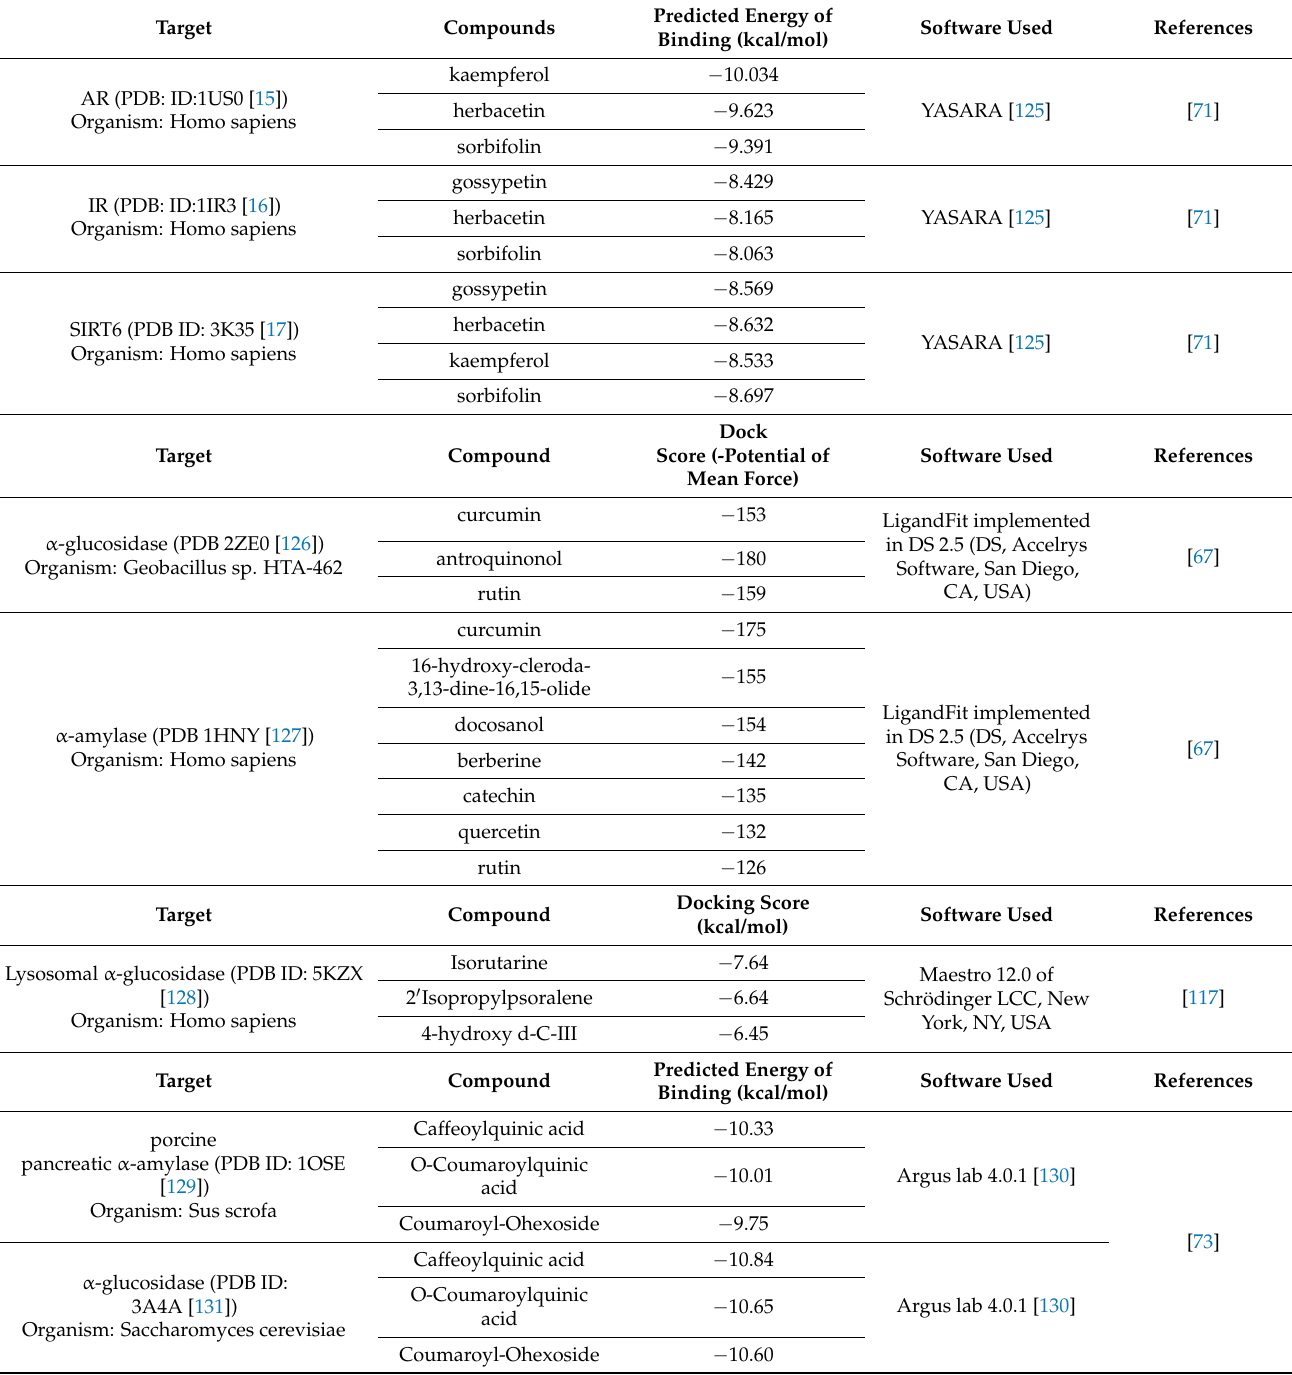
Table 1. Target receptors, the natural compounds with the best docking results from each study, docking scores and software used for